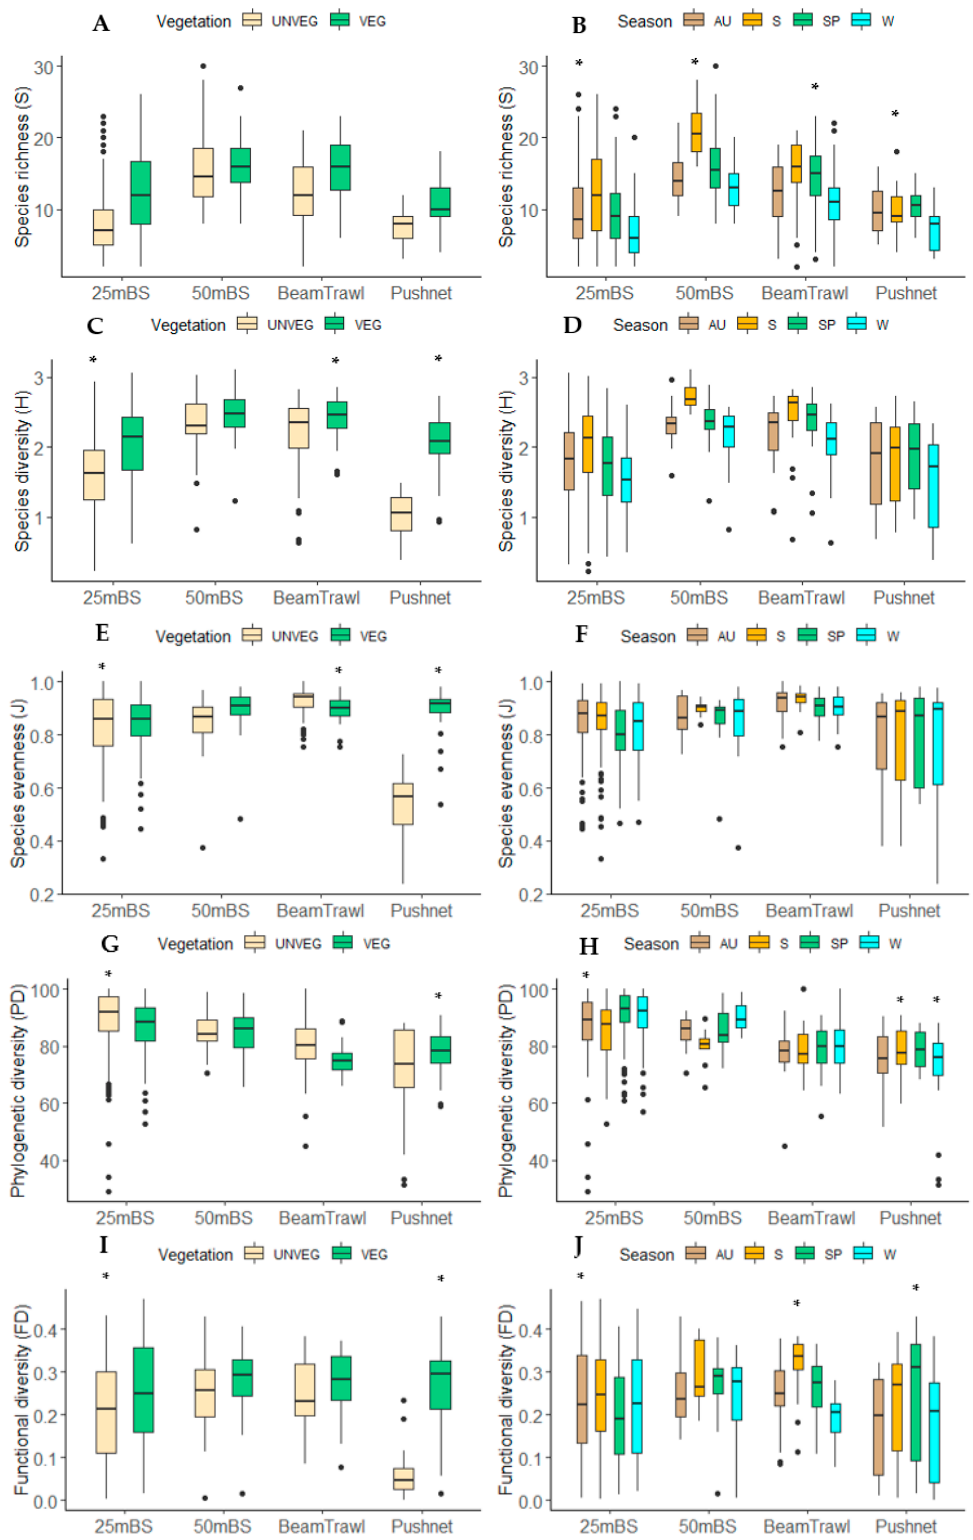
Figure 5. Box plots of indices of diversity split according to gear and presence/absence of vegetation (left column, panels ( A , C , E , G , I )), and gear and season (right column, panels ( B , D , F , H , J )). UNVEG— no vegetation, VEG—presence of vegetation; AU—autumn, S—summer, SP—spring, W—winter. * Represents significant differences ( p -values < 0.05). Black dots are outliers.